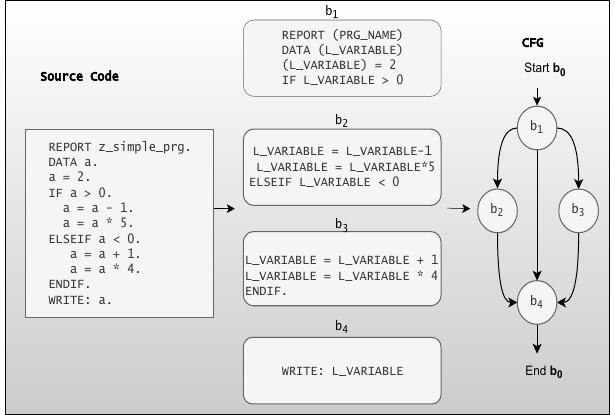
Figure 2. Control Flow Extraction